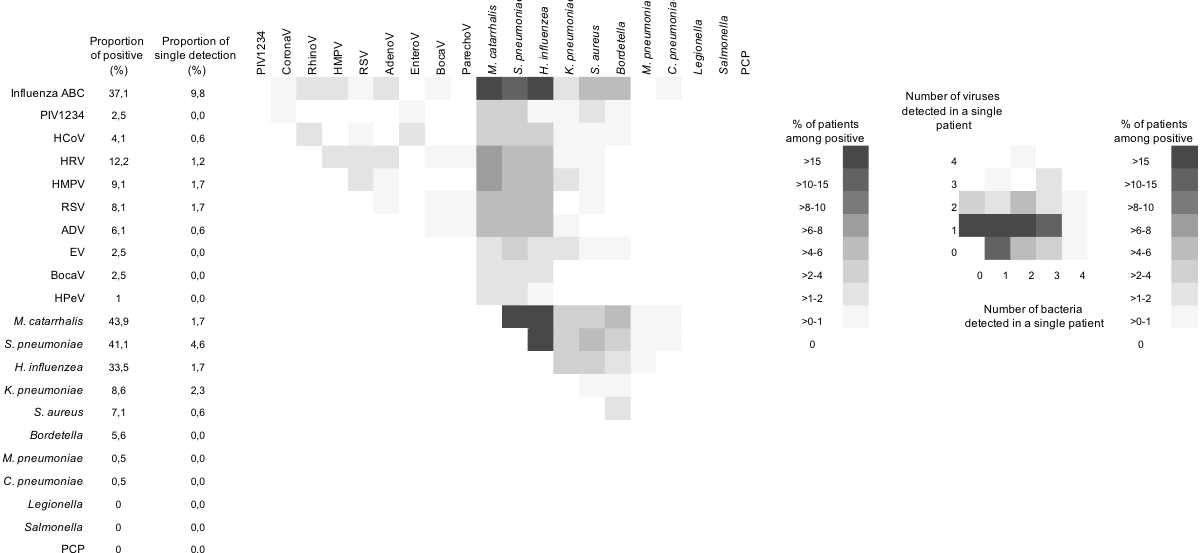
Table 1 19 . Two of those had completed PCV-13 vaccination. The microorganisms detected in the nasopharynx of those patients are shown in Table 4. Six children (5.2%) presented with severe pneumonia, one presented with seizure, two with severe respiratory distress, and three with vomiting.